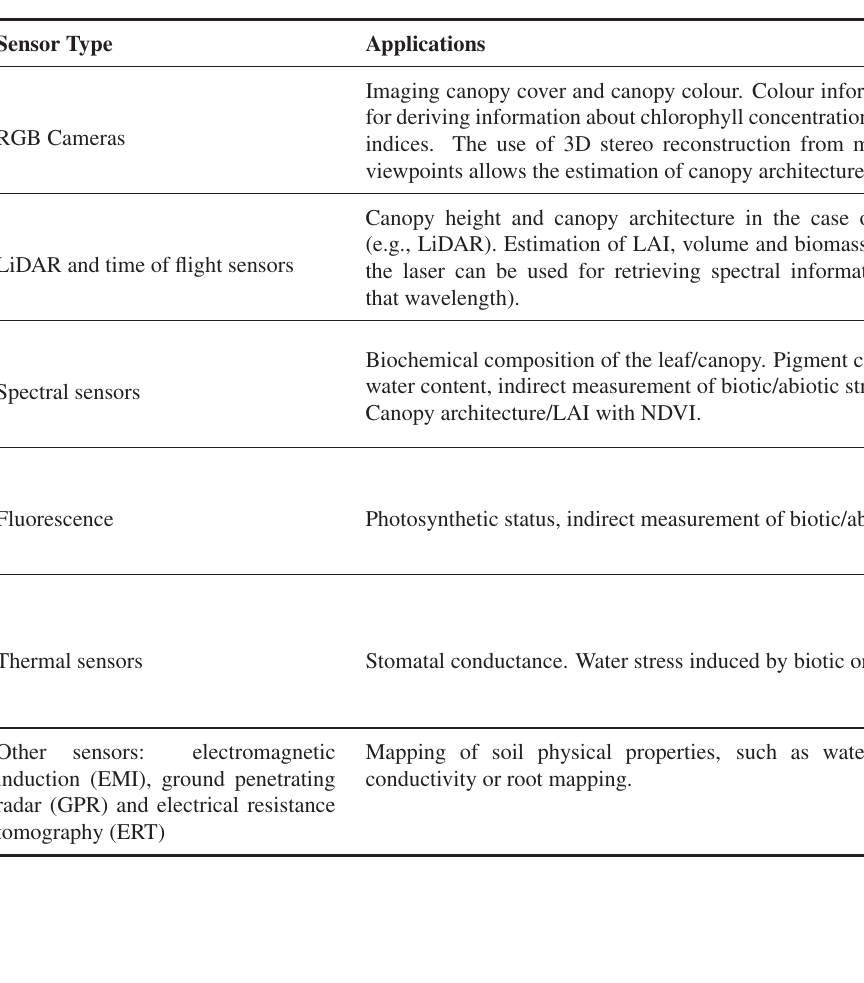
Table 2. Applications and limitations of common sensors mounted on field